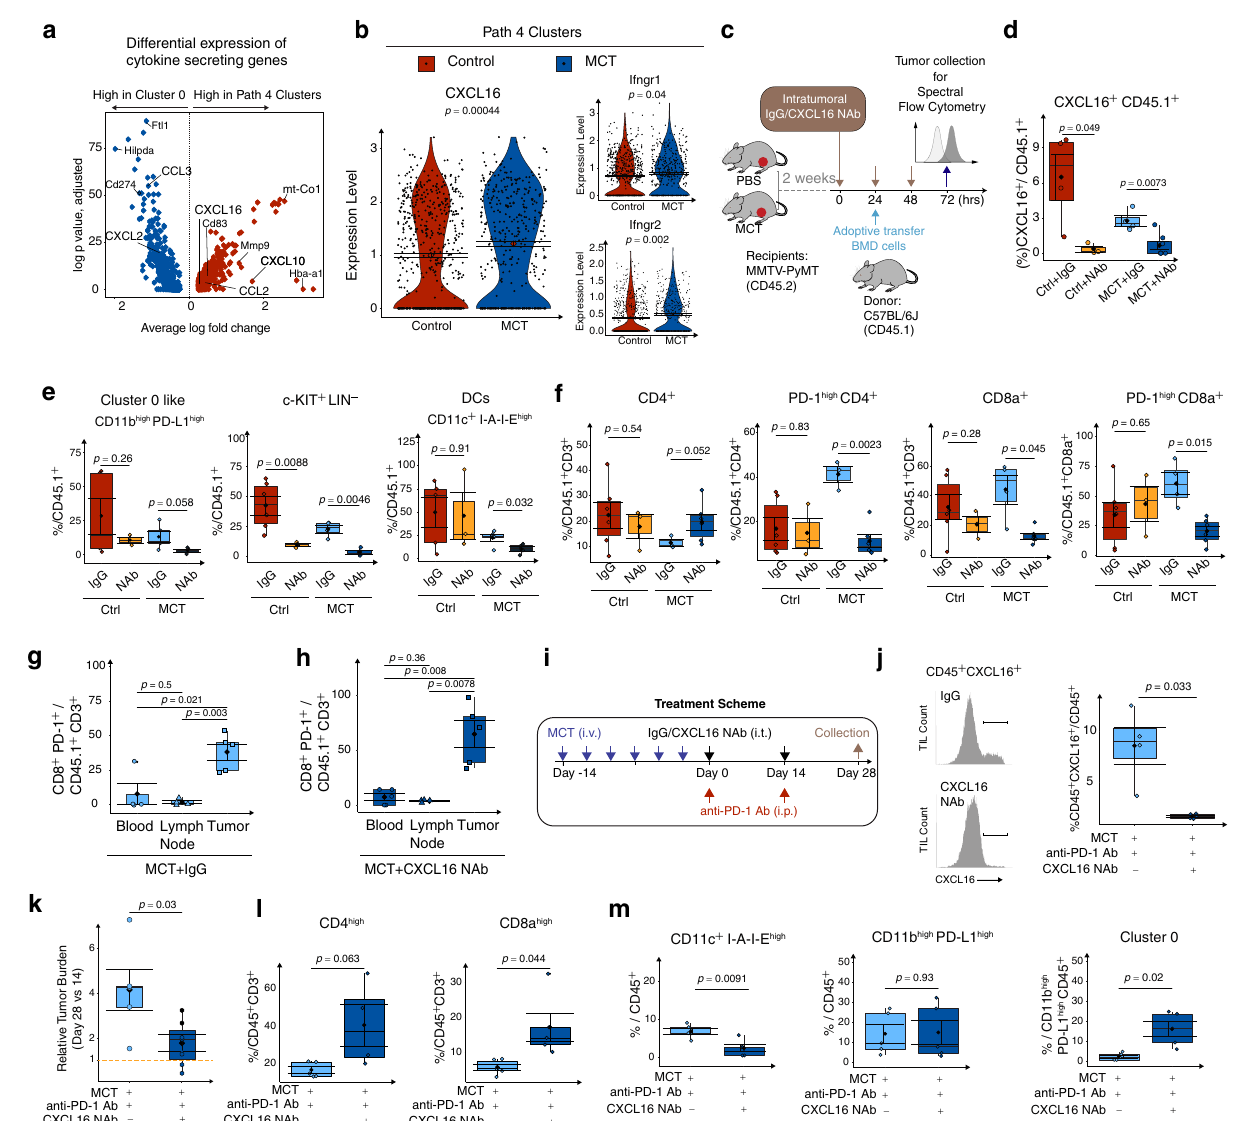
Fig.4|MCT-inducedCXCL16mediatesintratumoralimmunedynamicsandICB ef fi cacy. a Volcano plot shows genes expressed differentially between Cluster 0 andDCclusters. b ViolinplotsshowtheexpressionofCXCL16,IFN- γ r1,andIFN- γ r2 bytheDCclusters. c SchematicshowstheintratumoralIgGorCXCL16neutralizing antibody(NAb) injection into CD45.1 + cell adoptive transfer recipients treated